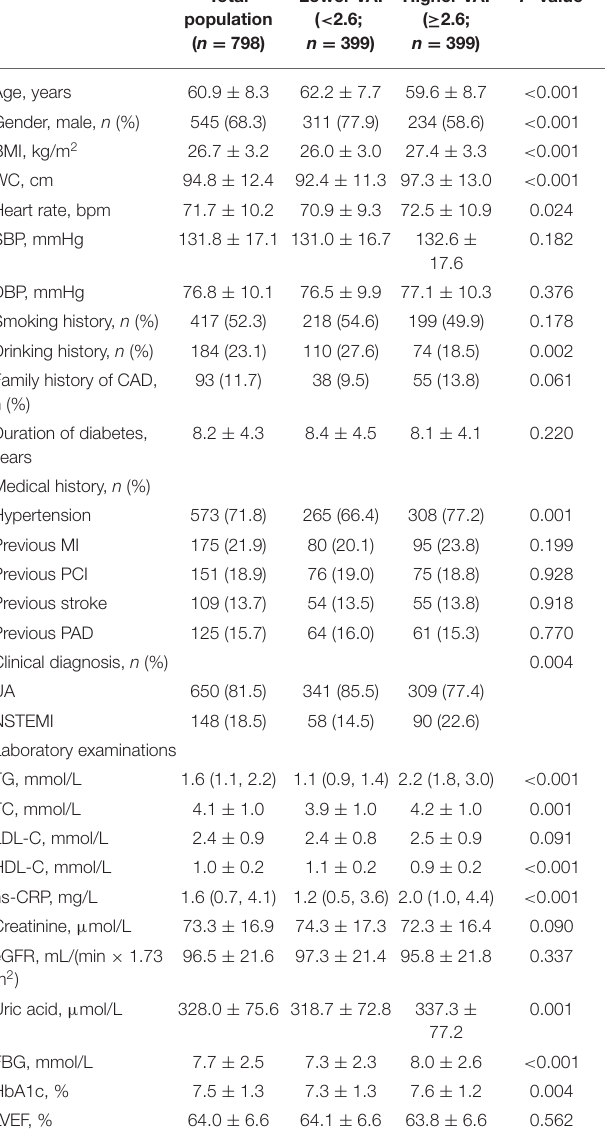
the primary endpoint and each component, showed that the